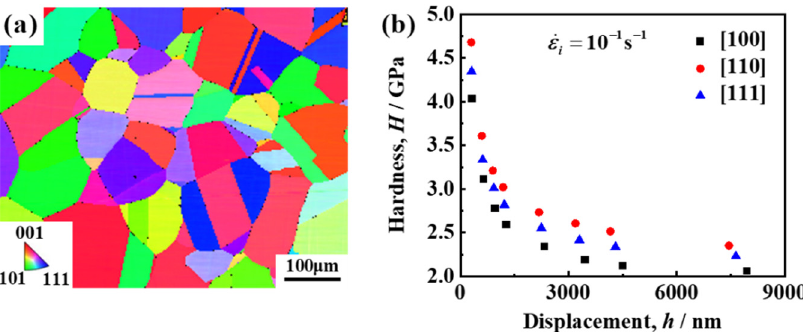
Figure 1. ( a ) The EBSD inverse pole figure of the fully recrystallized coarse-grained microstructure; ( b ) the hardness-displacement relation obtained from the CSR tests in the [001]-, [101]- and [111]- oriented grains at ε i = 10 − 1 s − 1